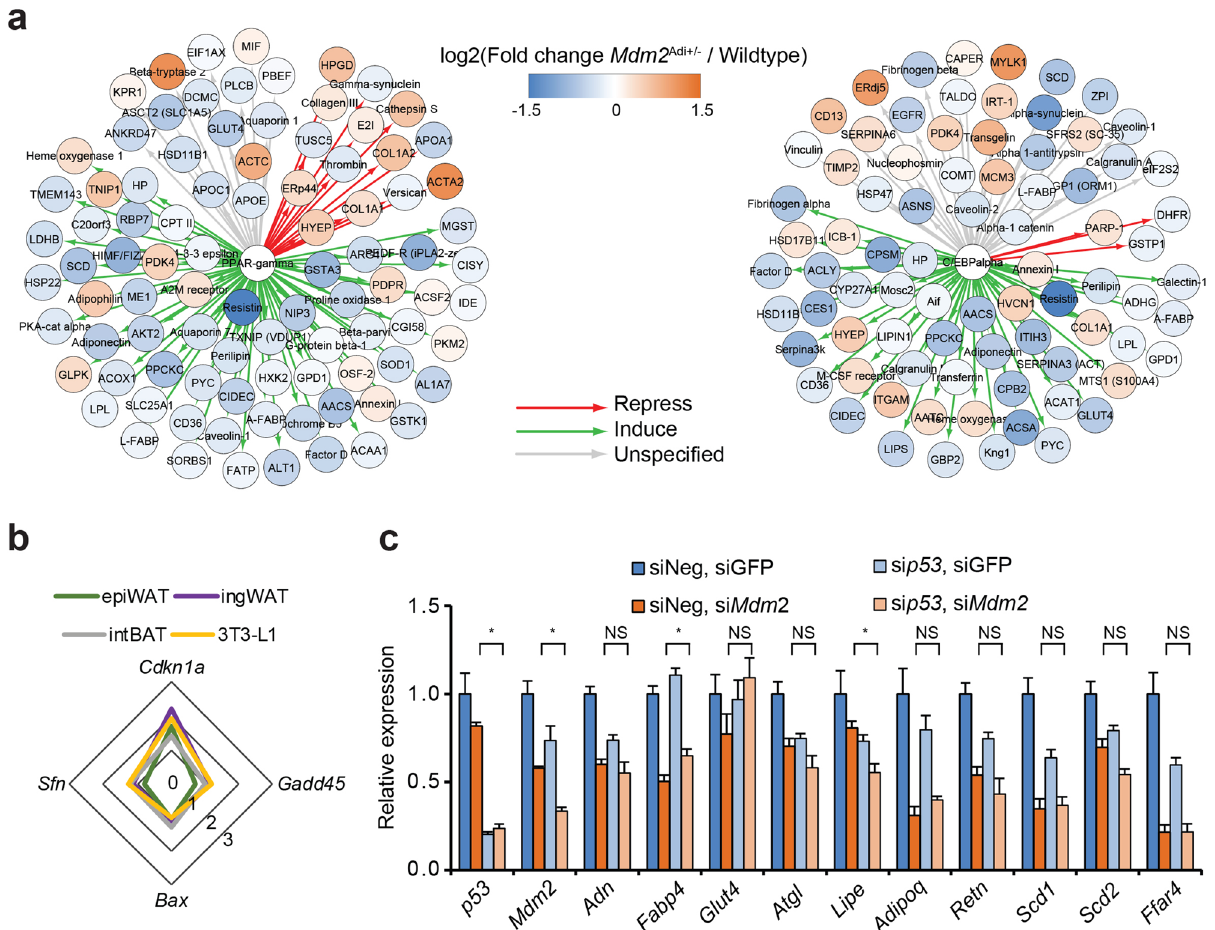
Figure 4. MDM2 regulation of Ffar4 expression is at least partially independent of p53. ( a , b ) Data from male wildtype (N = 8) and Mdm2 Adi+/− (N = 7) mice after 15 weeks on high-fat diet. ( a ) Changes in target genes for PPARγ (left) and C/EBPα (right) in epiWAT of Mdm2 Adi+/− mice (N = 7) after 15 weeks on high-fat diet. Target genes were identified in MetaCore suite using shortest path in Build-network option and plotted in CytoScape 73 . Protein changes labeled with color with blue showing lowered levels in Mdm2 Adi+/− mice and orange higher levels. ( b ) Radar plot of relative Sfn , Bax , Gadd45 , and Cdkn1a mRNA levels in epiWAT, ingWAT and intBAT from high-fat fed Mdm2 Adi+/− mice (N = 7) compared to wildtype (N = 8) after 15 weeks on high-fat diet as protein GADD45; Cdkn1a , Cyclin-dependent kinase inhibitor 1. ( c ) Real-time qPCR-based quantification of p53, Mdm2, Adn, Fabp4 , Glut4 , Atgl , Lipe , Adipoq , Retn , Sdc1 , Scd2 , and Ffar4 in 3T3-L1 adipocytes